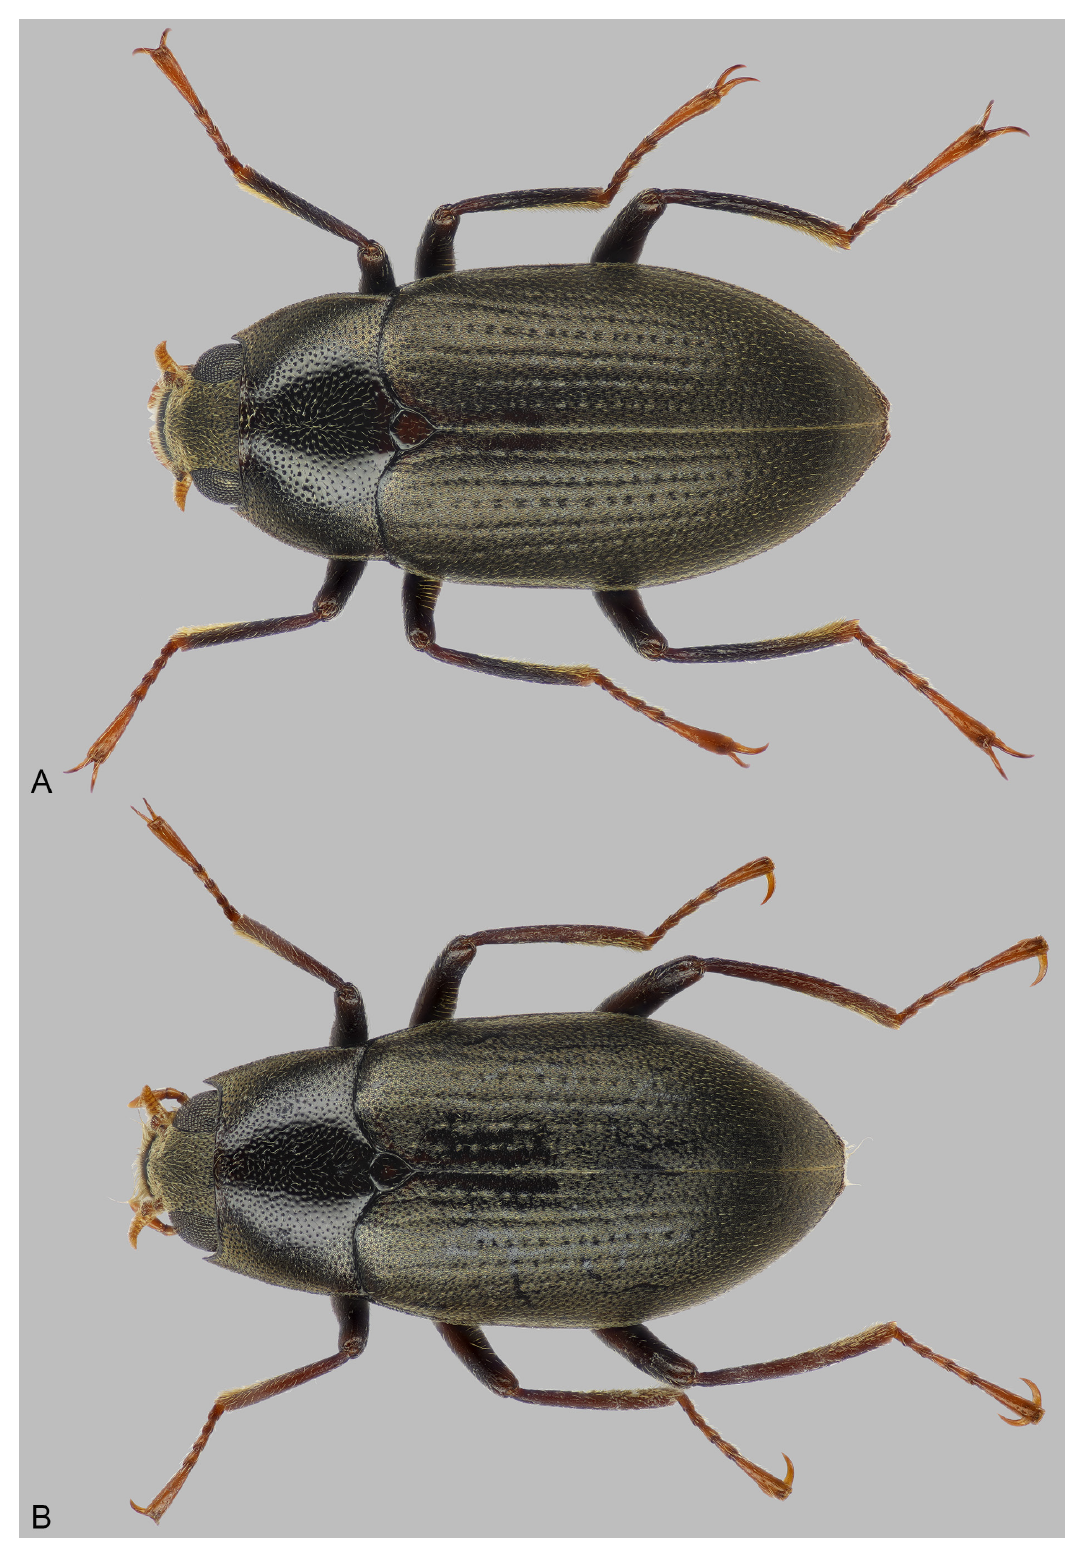
Fig. 5. Habitus. A . Elmomorphus brevicornis Sharp, 1888, ♂, length (anterior margin of clypeus to elytral apex): 3.7 mm (JKCB). B . Elmomorphus amamiensis Nomura, 1959, ♂, length (anterior margin of clypeus to elytral apex): 3.4 mm